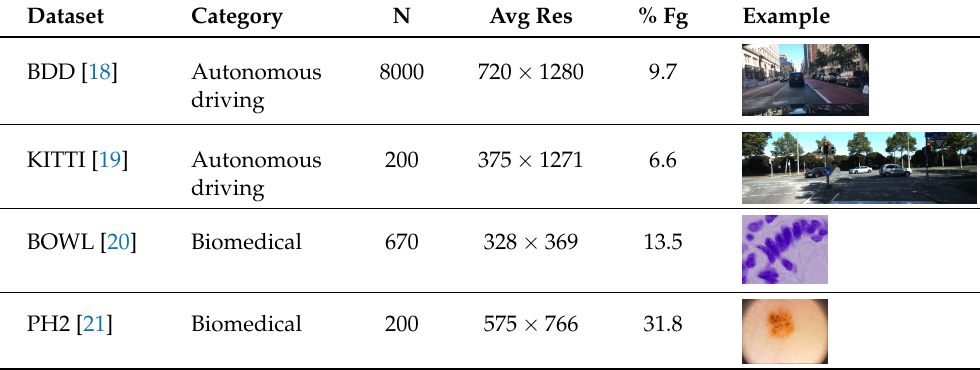
Table 2. Datasets for semantic